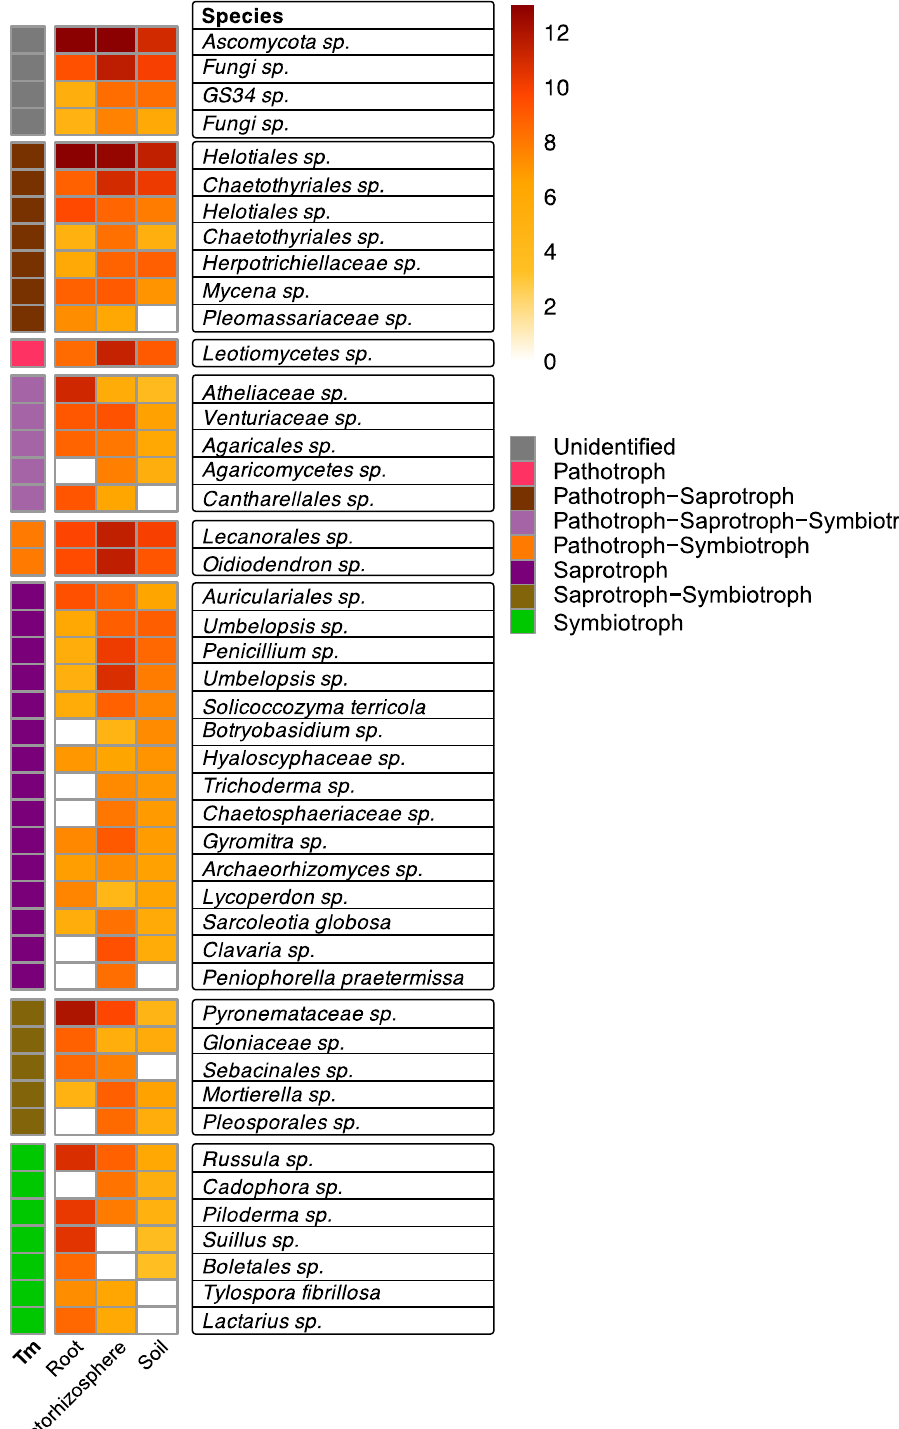
Figure 4. Heatmap depicting the most abundant amplicon sequence variants (ASVs) adding up to a total abundance of 50% of the total community of roots, ectorhizosphere or scarified soils. Left column colored by trophic modes annotated on FUNGuild V1.1. Scale is log 10 of the sequencing reads. The complete list of ASVs can be found in Table S3. When looking closer at the abundances of ECM fungal ASVs in roots, ectorhizosphere and bulk soil, we observed three differing patterns of occurrence (Figures 4 and